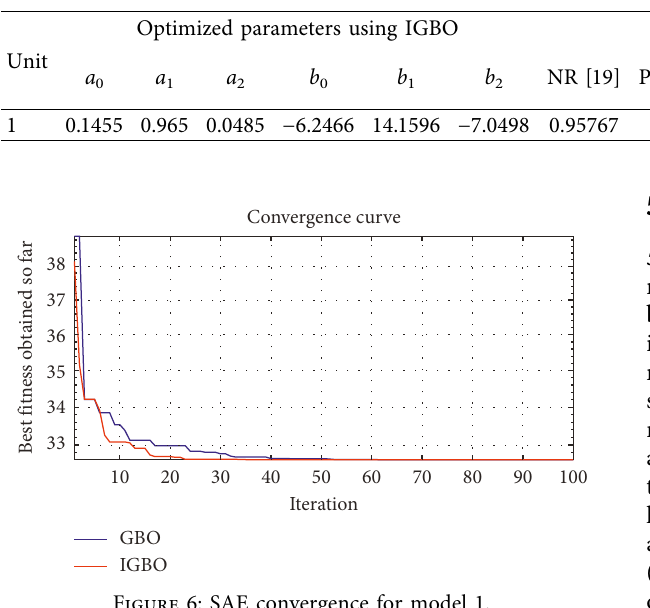
Figure 6: SAE convergence for model